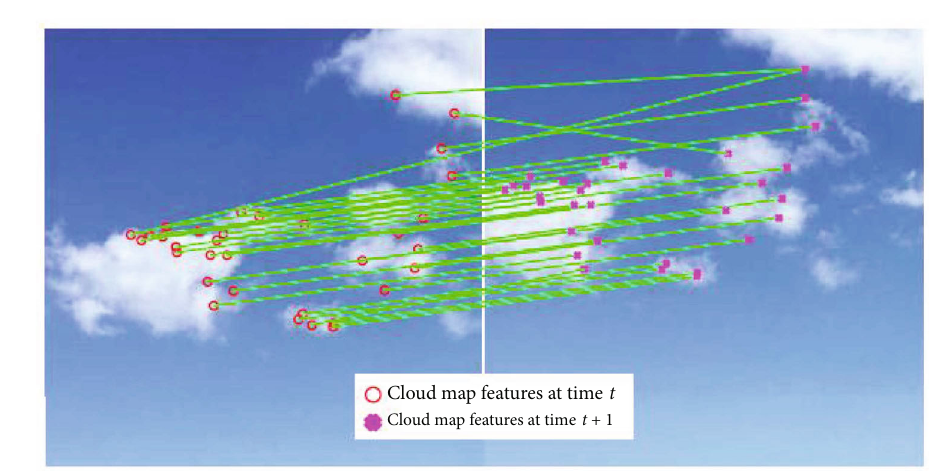
Algorithm 1: IRANSAC algorithm.